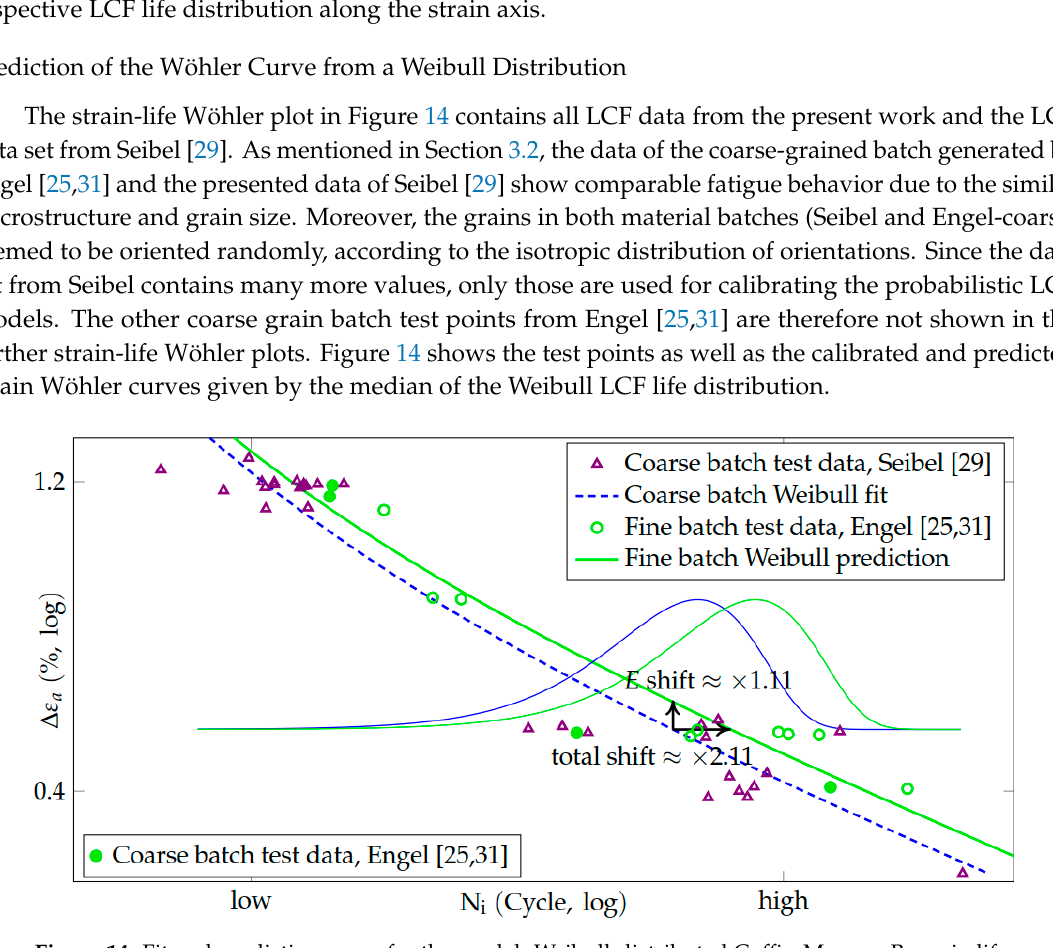
Figure 14. Fit and prediction curve for the model: Weibull-distributed Coffin-Manson-Basquin life.